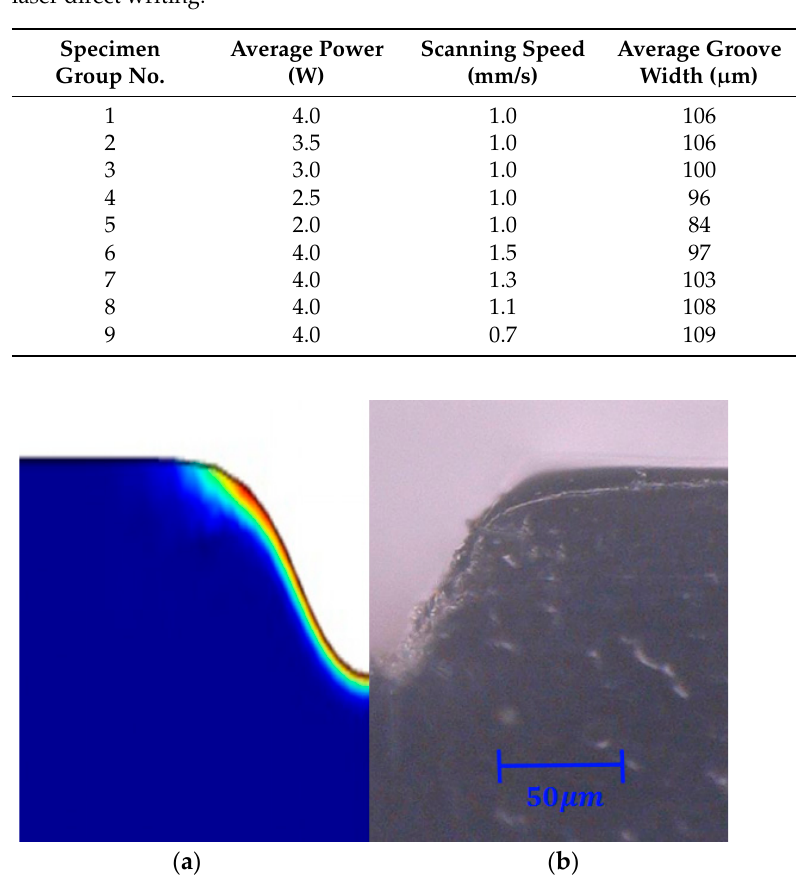
Figure 8. Comparison between simulated grooves ( a ) and direct-written grooves ( b